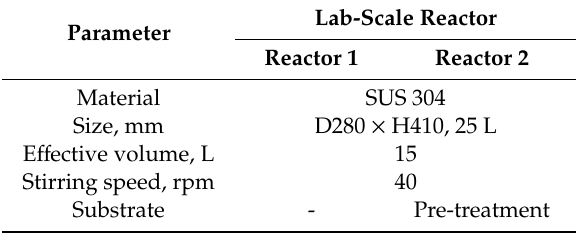
Table 4. Lab-scale experiment features for a comparison before and after thermal